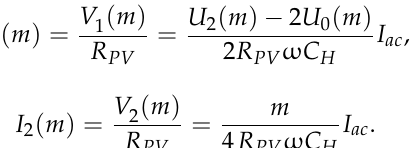
Figure 8. Amplitude of dominating low-frequency PV current harmonics as a function of the modulation index in the case C H = 1 mH, I ac = 1 A, and R PV = 40 Ω .